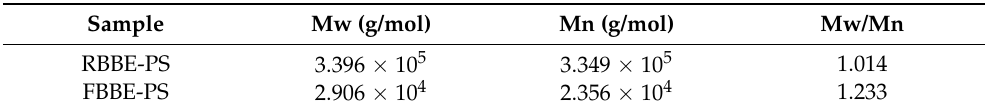
Figure 1. Effects of fermentation on the content of total polysaccharides in barley bran ( a ) and the HPSEC-RI-MALLS chromatograms ( b ) of polysaccharides from unfermented (RBBE-PS) and fermented barley bran extract (FBBE-PS). * p < 0.05. Table 1. Molecular weight of polysaccharides from unfermented (RBBE-PS) and fermented barley bran extract (FBBE-PS).